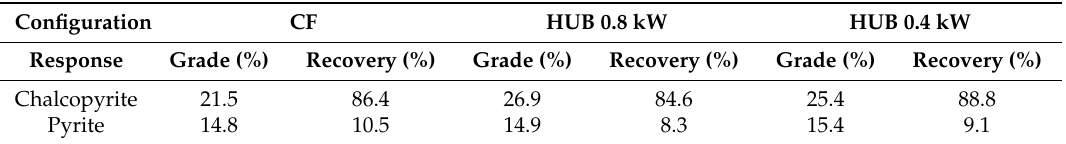
Table 6. Final grades and recoveries of chalcopyrite and pyrite obtained without the acoustic waves and with a combination of homogenizer and ultrasonic